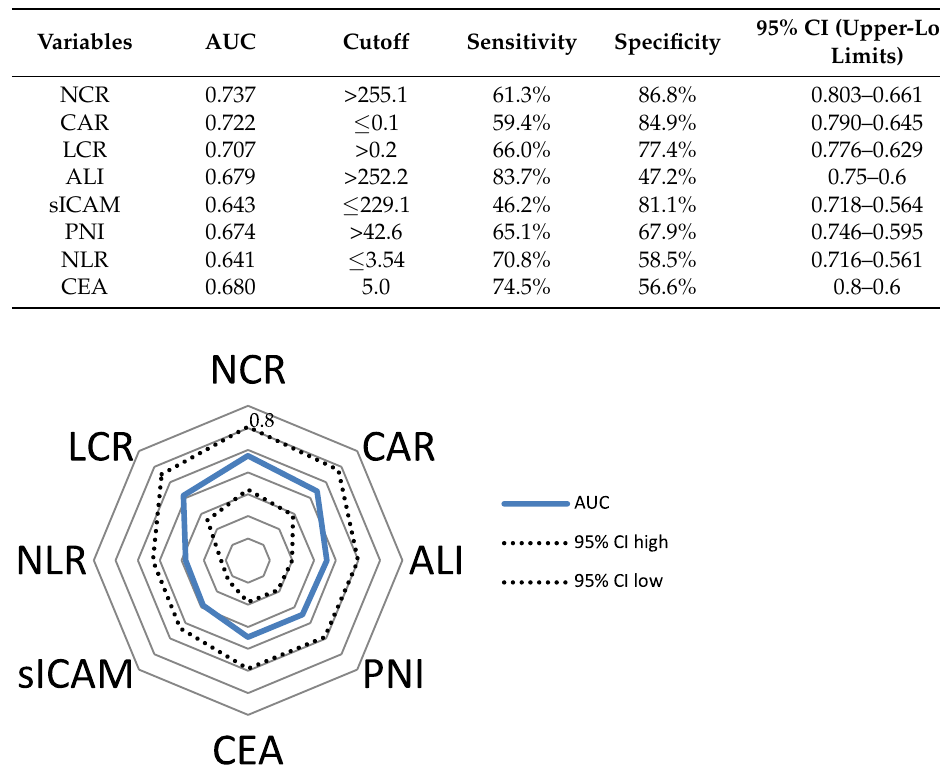
( b ) Figure 2. Clinical significance of the preoperative NCR in patients with colon cancer from the dis- covery cohort according to ( a ) the UICC classification: NCR levels were significantly decreased in a staged dependent manner; and ( b ) sidedness: significantly decreased NCR levels were observed in patients with right-sided colonic cancer.